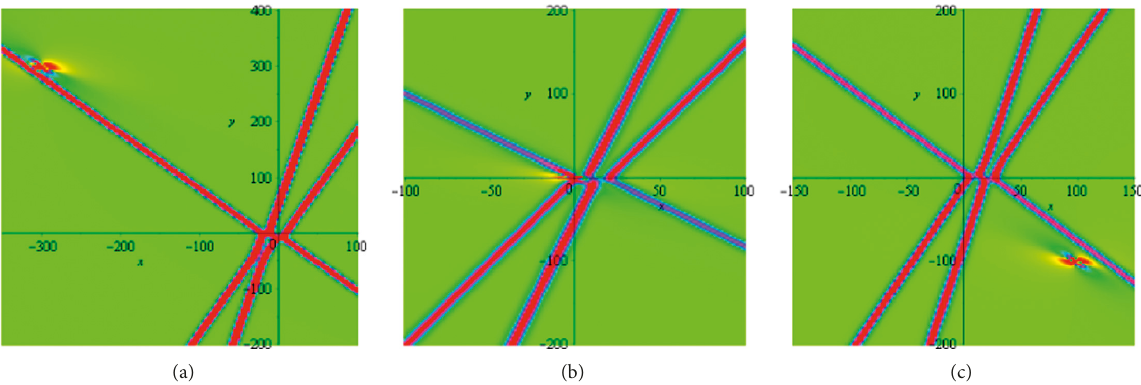
( t ) � 1 , ϕ ( t ) � cos ( t + 3 ) , c 1 9